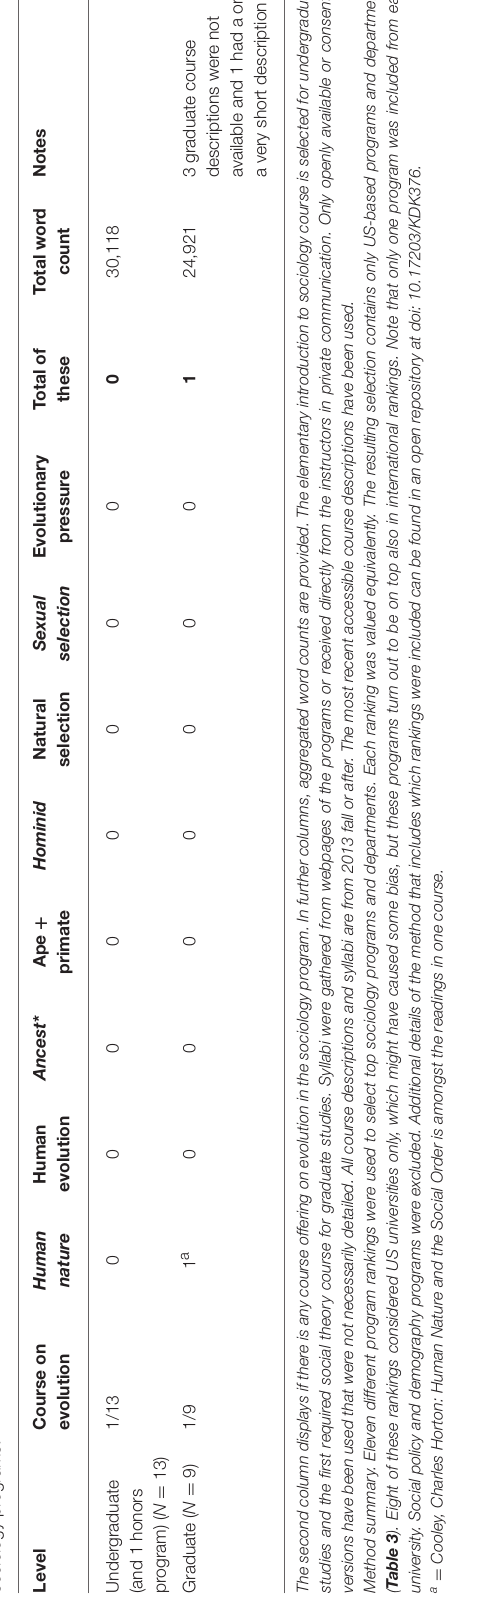
TABLE 3 | The composite ranking of sociology